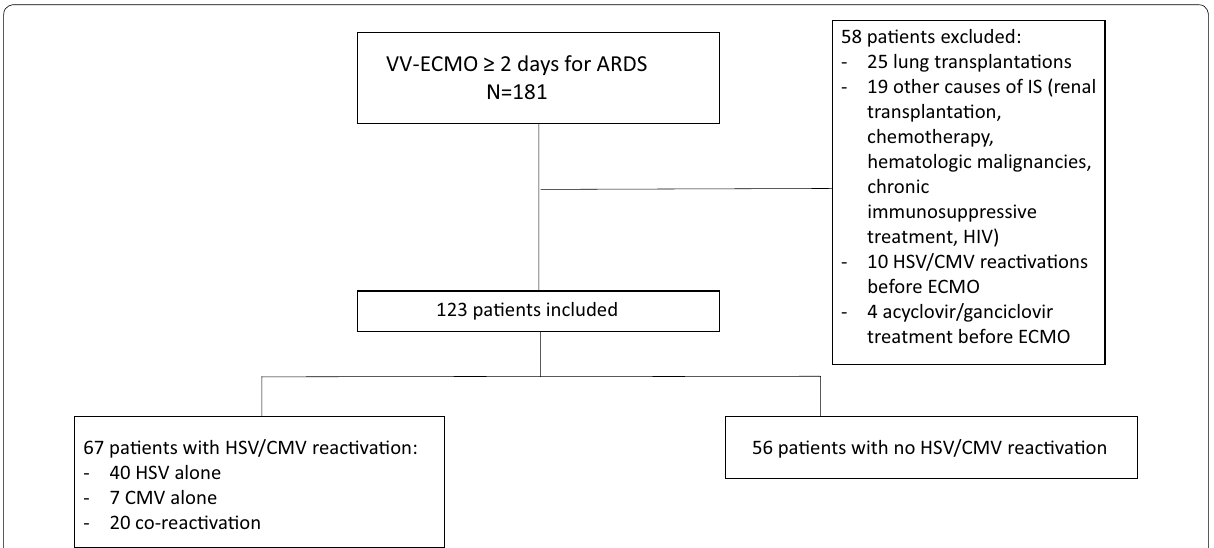
Fig. 1 Study flowchart. CMV Cytomegalovirus, HSV herpes simplex virus, IS immunosuppression, VV-ECMO veno‑venous extracorporeal membrane